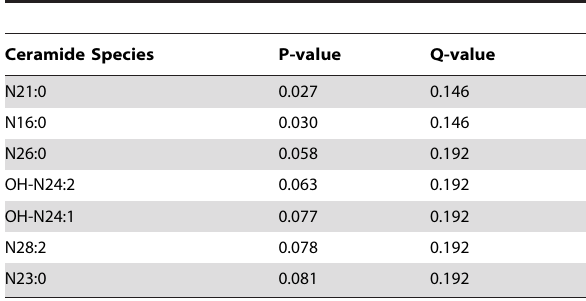
Table 4. Ceramide species significantly different between AD and control groups a .